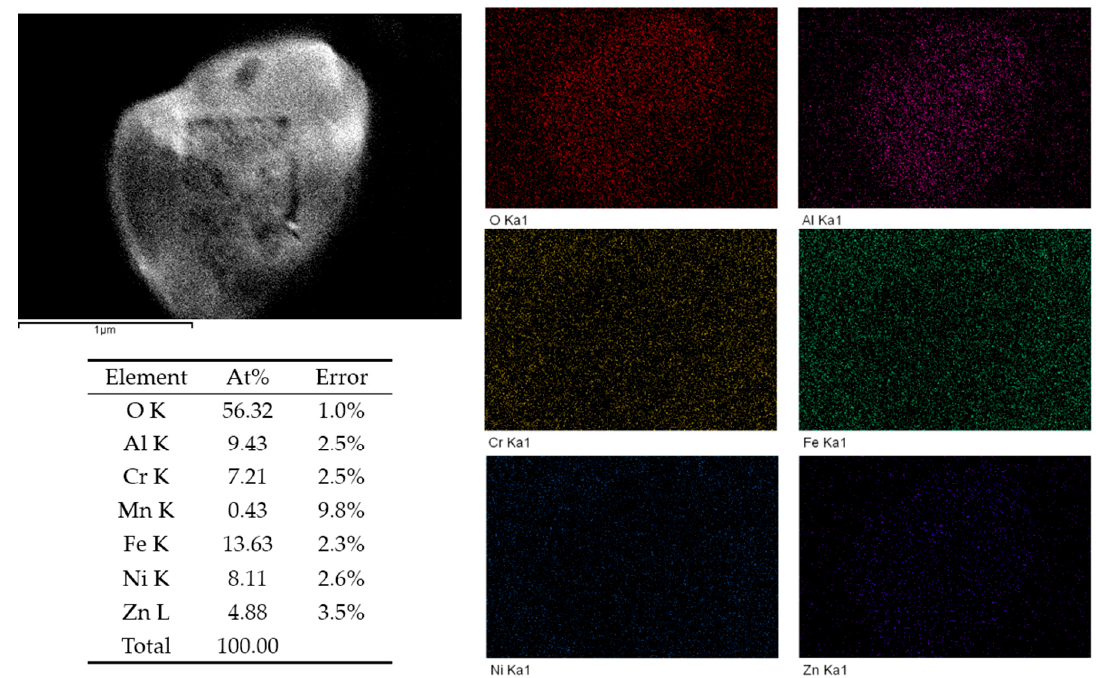
Figure 14. The Surface morphology, element distribution and composition analysis of the observed crystal formed on materials with the zinc–aluminum treatment.